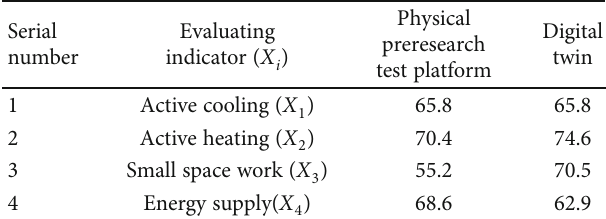
Table 4: User rating table of functional requirements.